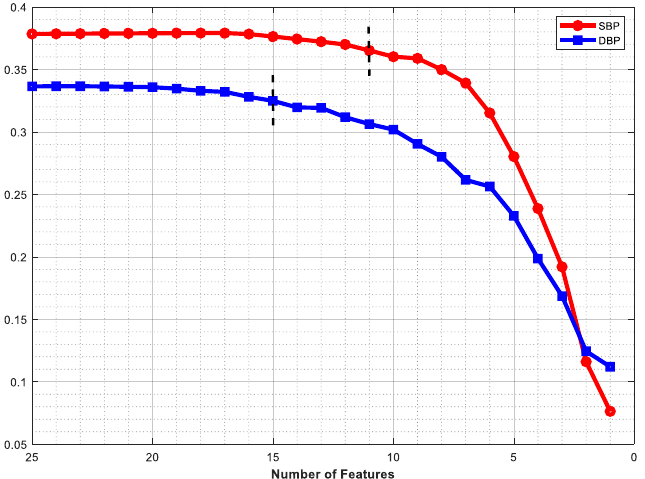
Figure 6. GCMI between different numbers of features and BP (the black dotted line represents the cut-off point for feature selection).